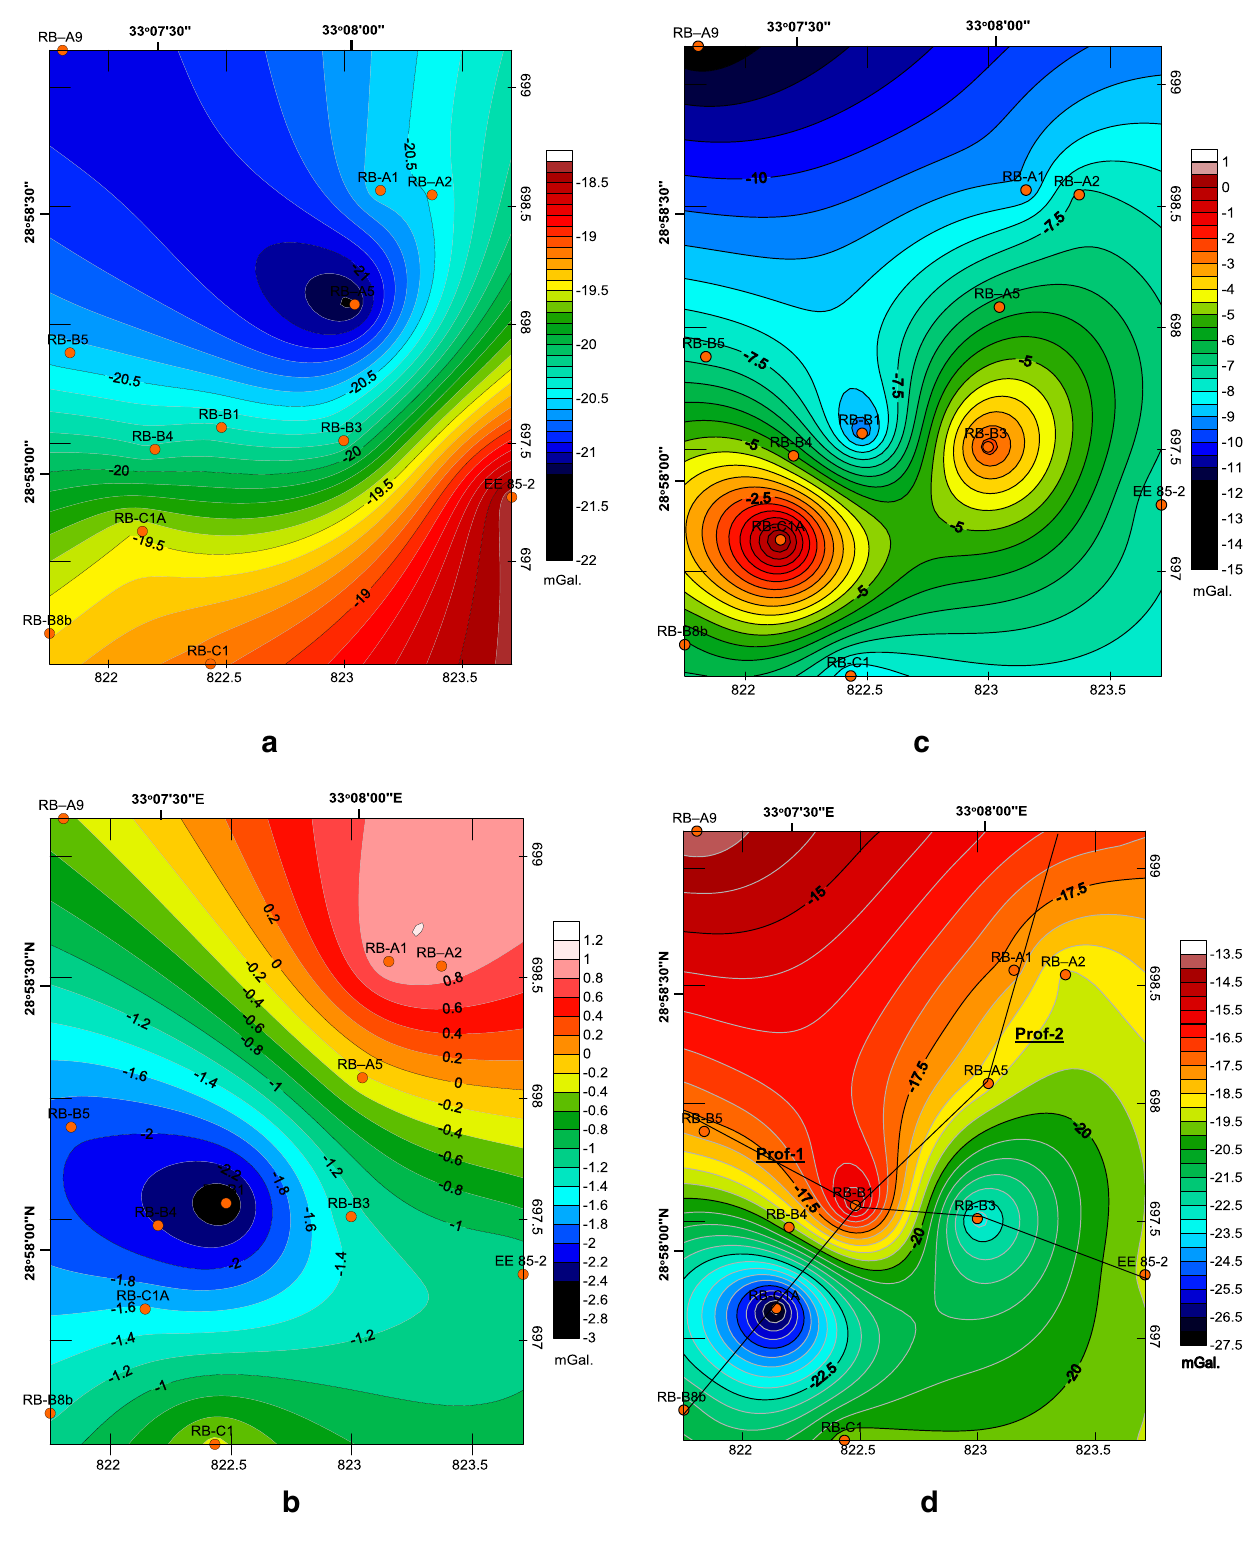
Fig. 8 a Gravity effect of post-evaporite rocks. b Gravity effect of evaporite rocks. c Gravity effect of pre-evaporite rocks. d Gravity effect on basement